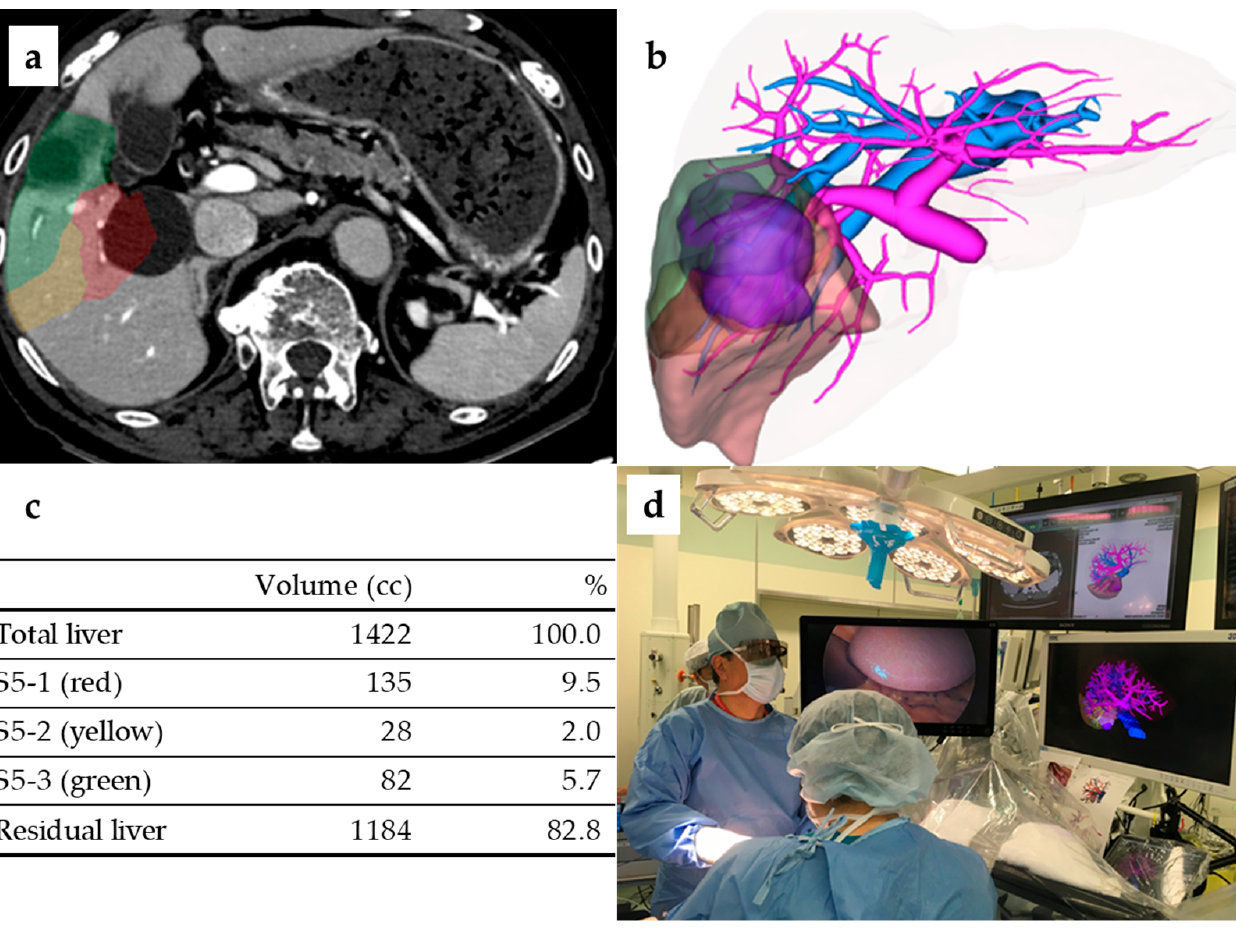
Figure 1. Preoperative 3D simulation (S5 segmentectomy) and intraoperative 3D monitor. ( a ) Seg- Figure ment5 in this case consists of three cone units. ( b ) 3D-constructed image. ( c ) Liver volume calcula- tion per cone unit. ( d ) 3D glasses were used during surgery, and simulated images were projected on a 3D monitor (center).